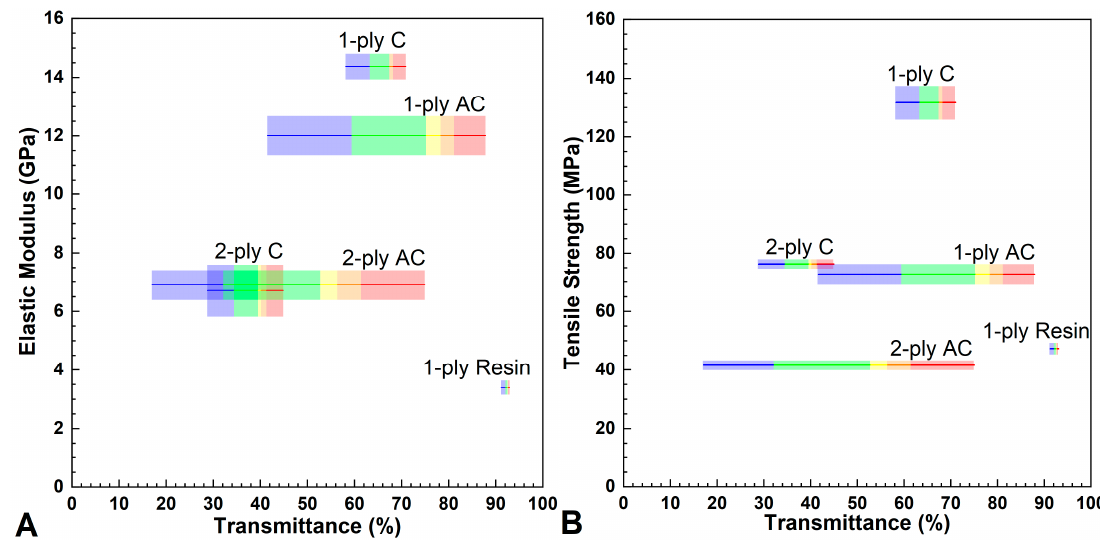
Figure 5. Comparison of the optical transmittance to ( a ) elastic modulus and ( b ) tensile strength to visualize the how each TWC is transmitting light across the visible spectrum. Mechanical data for the 1-ply samples utilized the [0°] properties. Thicknesses—1-ply C: 1.63 mm, 1-ply AC: 1.66 mm, 1-ply resin: 1.30 mm, 2-ply C: 3.18 mm, 2-ply AC: 3.42 mm.